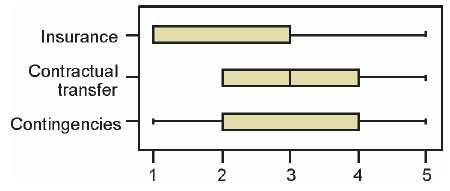
Fig. 9. Risk response technique usage in PPP